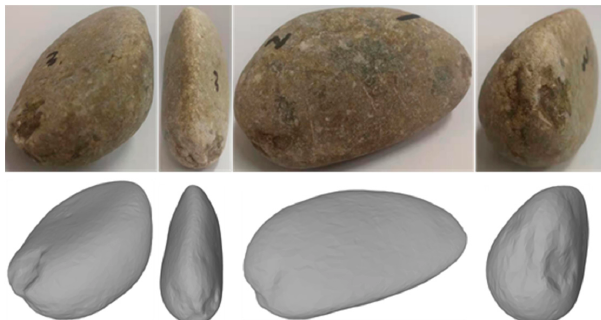
Figure 2. Illustrations for a rounded stone. The upper ones are four photos for the real rounded stone while the lower ones are the corresponding reconstructions by Artec 3D laser scanner.